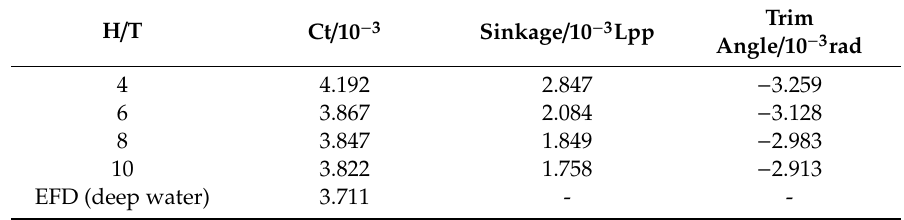
Table 14. The results of resistance, sinkage and trim.